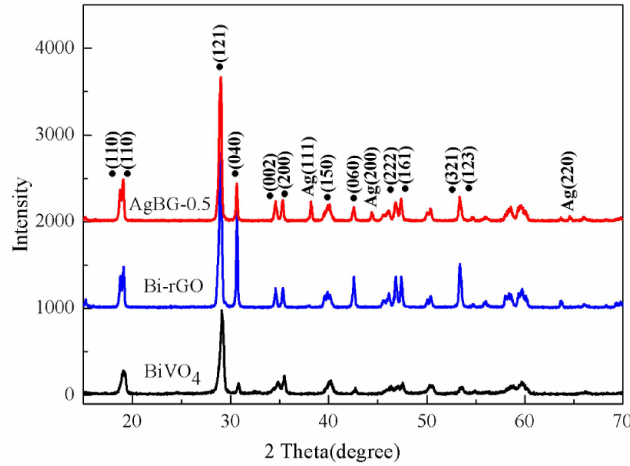
Figure 1. XRD patterns of pure BiVO 4 and Bi-rGO and AgGB-0.5 composites.